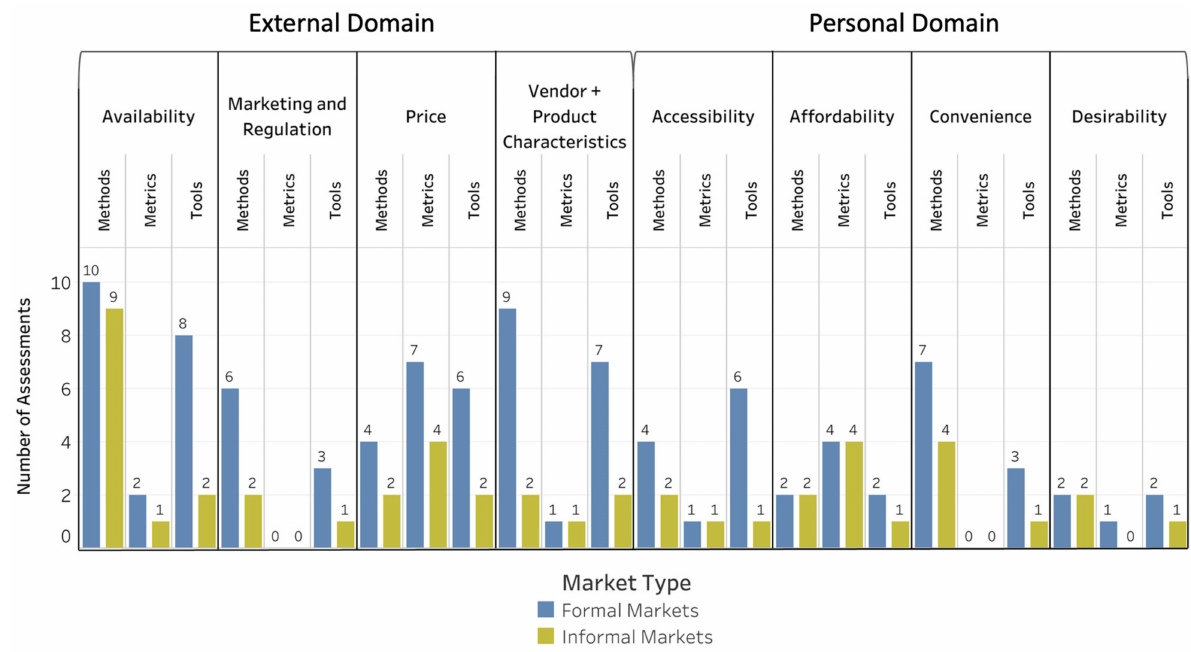
Figure 2. Market Food-Environment Assessments Suitable for LMICs with Minor Modification. Number of methods, tools, and metrics found suitable based on the scoring exercise with minor modification in LMICs.